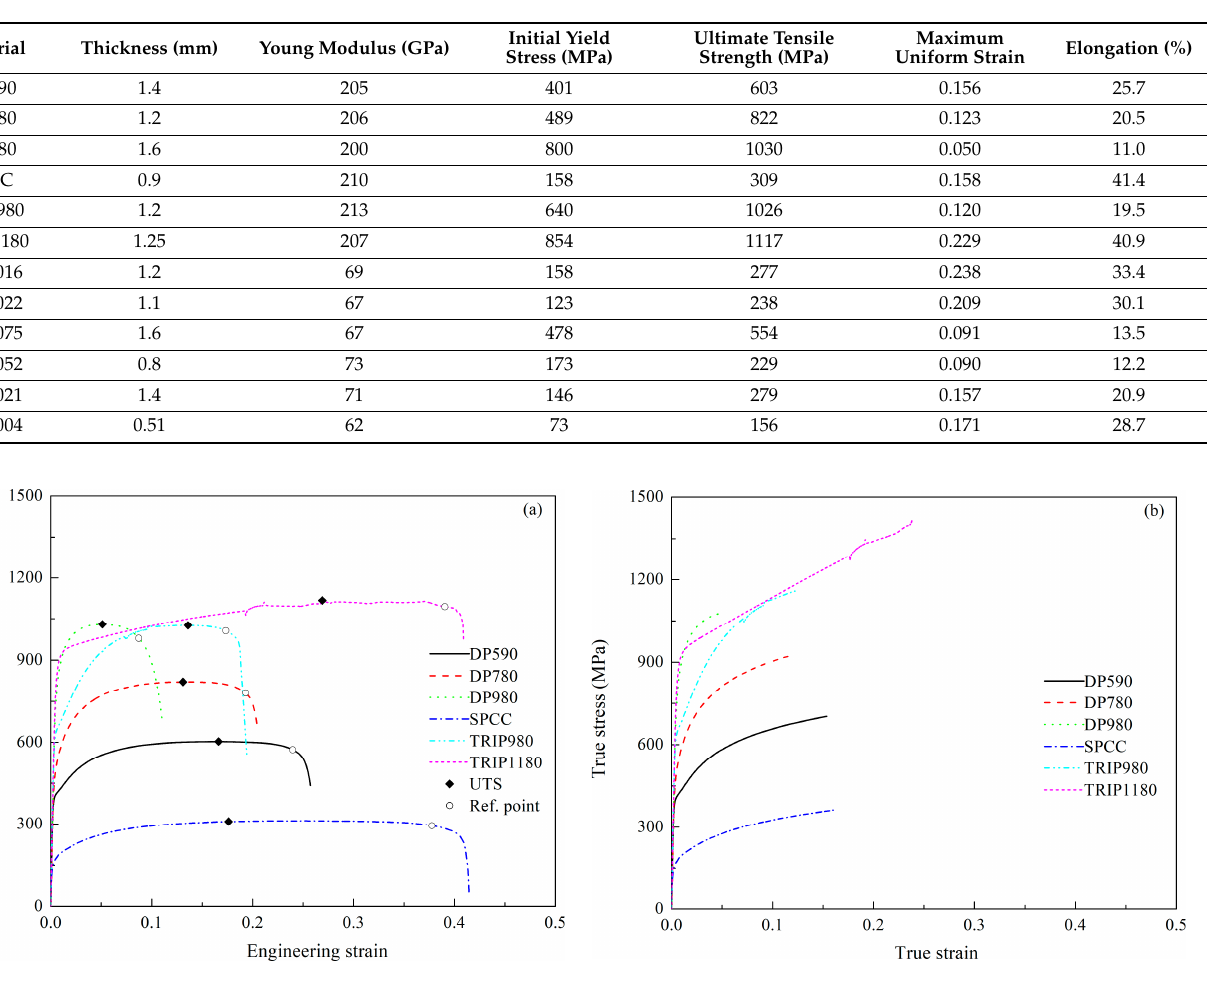
Figure 3. Stress-strain data obtained from uniaxial tensile tests for six steel sheets. ( a ) Engineering stress-strain curves. ( b ) True stress-strain curves.